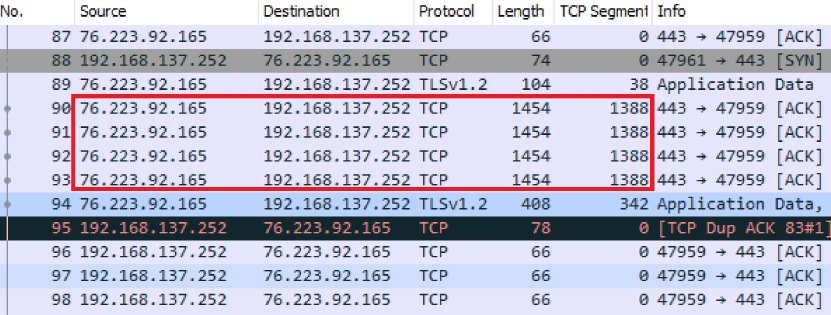
Figure 13. Traffic patterns of incoming calls to User